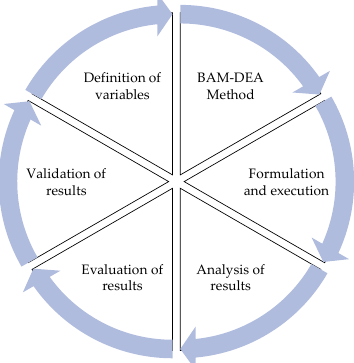
Figure 1. Model methodology to evaluate the efficiency of small regional airports in Colombia using BAM–DEA. Source: Authors’ own creation.